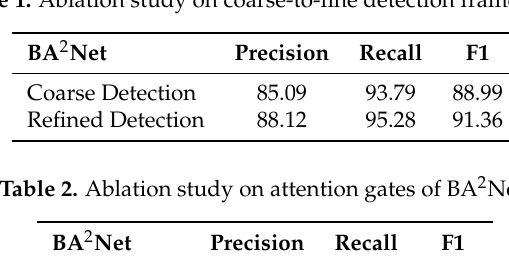
Table 1. Ablation study on coarse-to-fine detection framework.